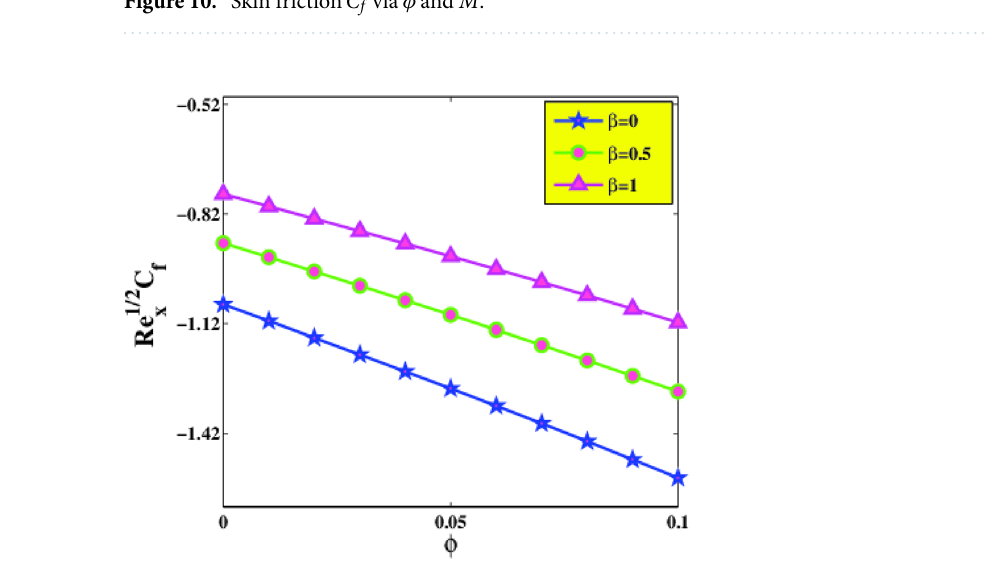
Figure 10. Skin friction C f via φ and M .